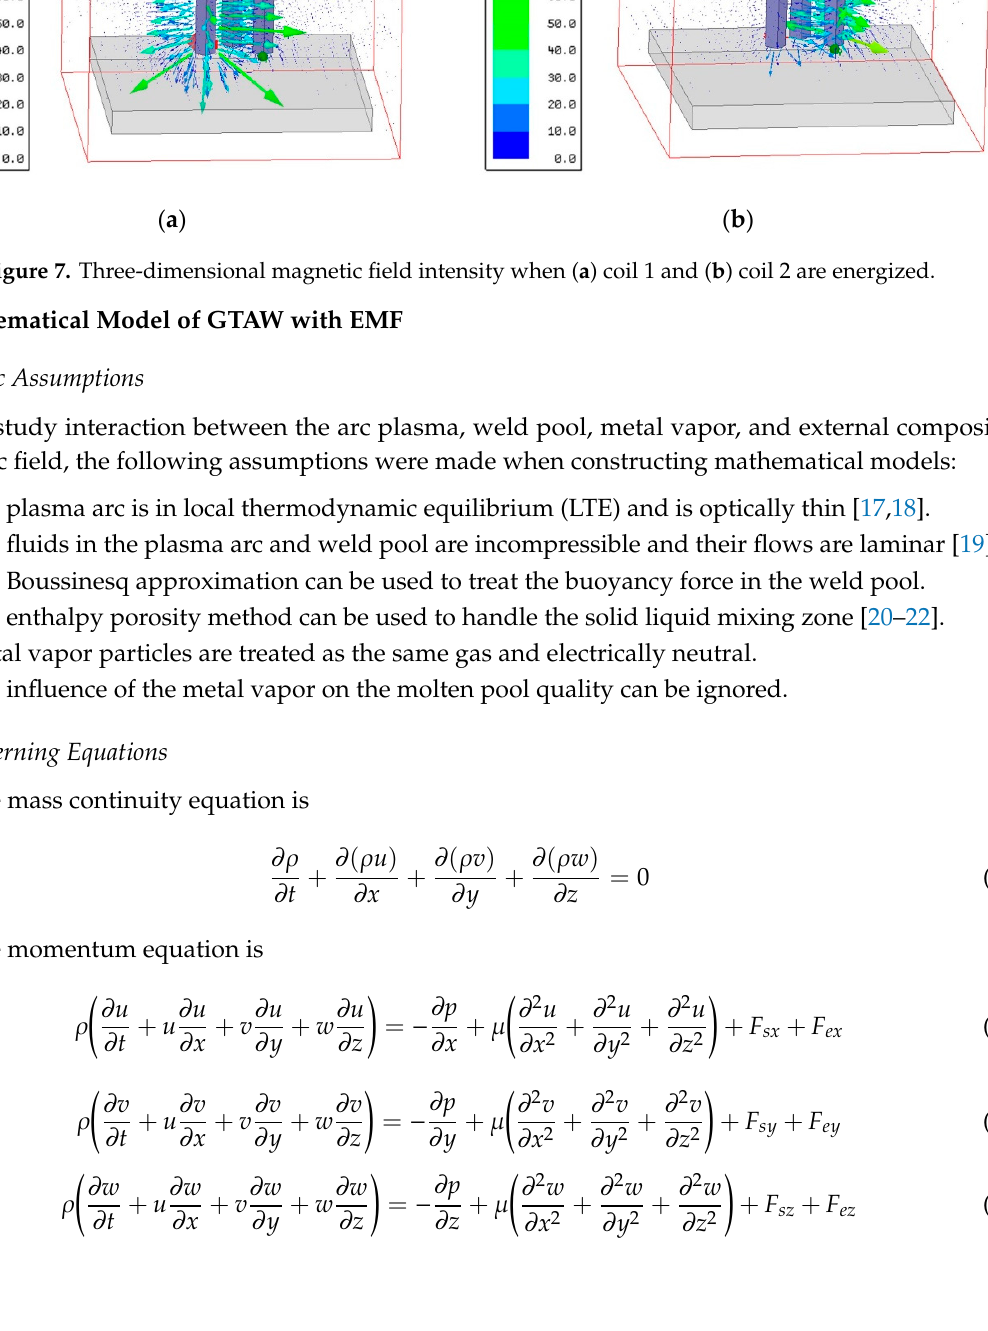
Figure 6. Various regions in the model.